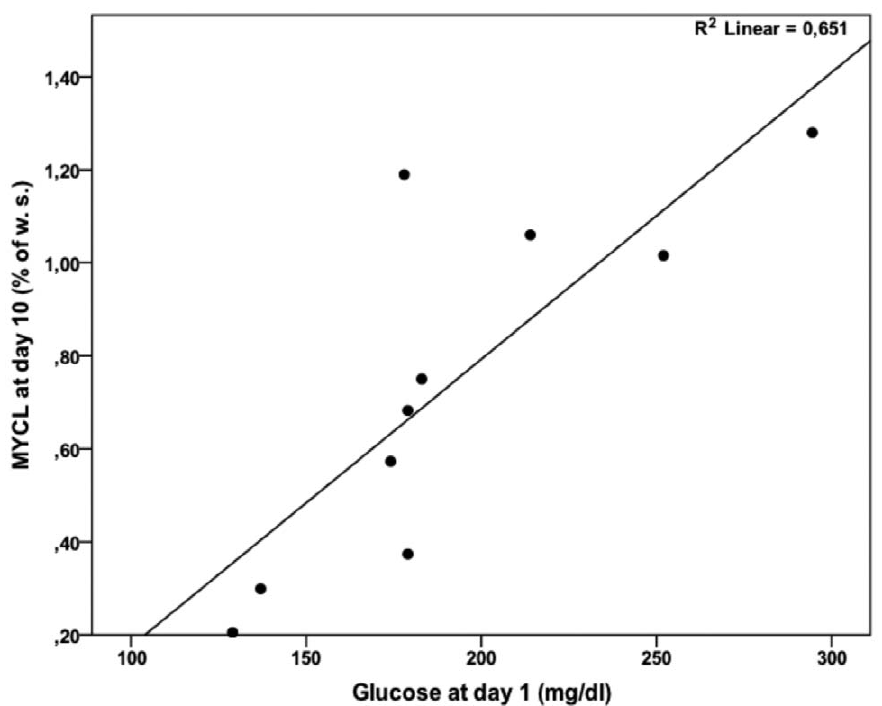
Figure 3. Association between mean glucose concentrations at day 1 and MYCL content at day 10 of IT.